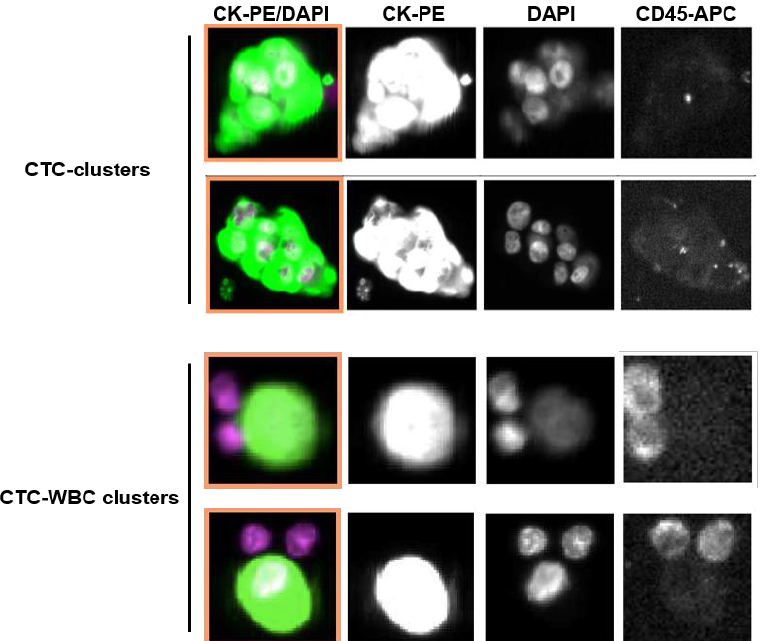
Figure 1. Representative images of circulating tumor cell (CTC)-clusters and CTC-WBC (white blood cell) clusters isolated from 7.5 ml of blood from metastatic breast cancer (MBC) patients captured by CellSearch® system. CTCs were identified by round-oval morphology, positive staining for cytokeratins 8, 18, and 19 (CKs-PE, phycoerythrin-conjugated antibody) and DAPI (DNA dye), and negative staining for CD45 (CD45-APC, allophycocyanin-conjugated antibody